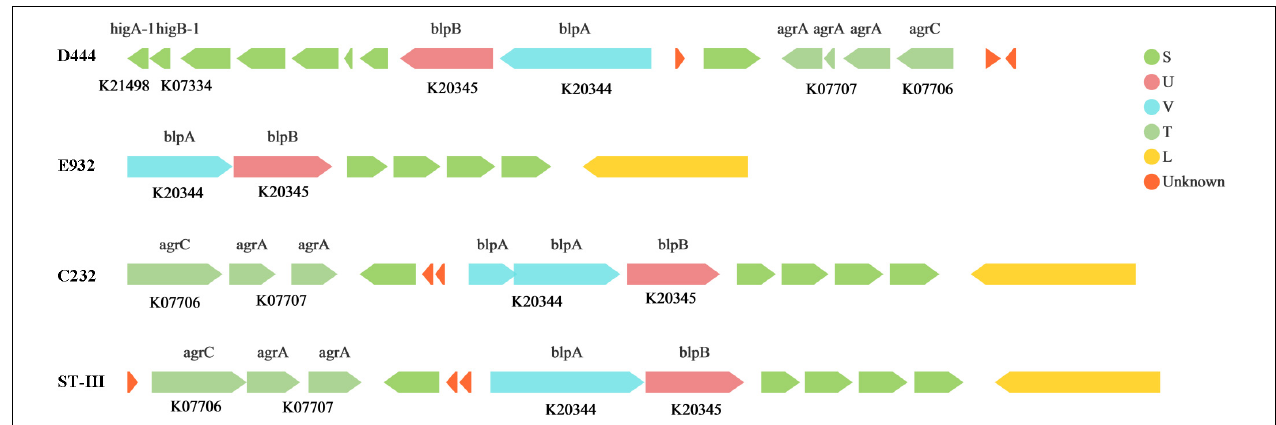
FIGURE 5 | Bacteriocin synthesis gene clusters The arrow represents a gene, above the arrow is the name of the gene, and below the arrow is the Ko number of the gene. The length of the arrow represents the length of the gene. The direction indicates whether the gene is encoded by the justice or antisense chain. The different color represents its function in the COG